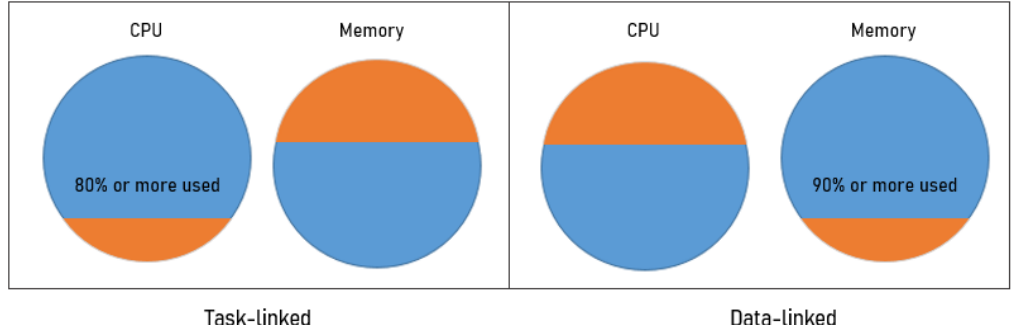
Figure 1. The resource range for data-linked and task-linked.